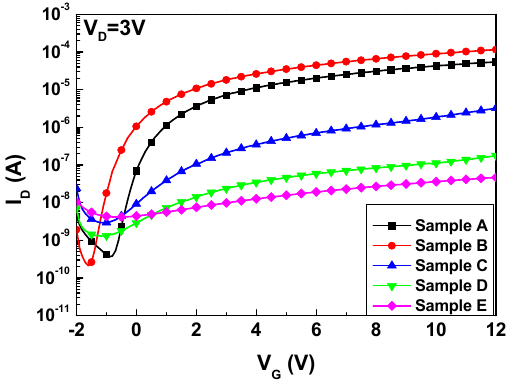
Figure 5. Transfer curve of InTiZnO TFTs with different oxygen flow ratios. Table 1. Electronic parameters of each unannealed InTiZnO TFT measured in dark at room temperature.